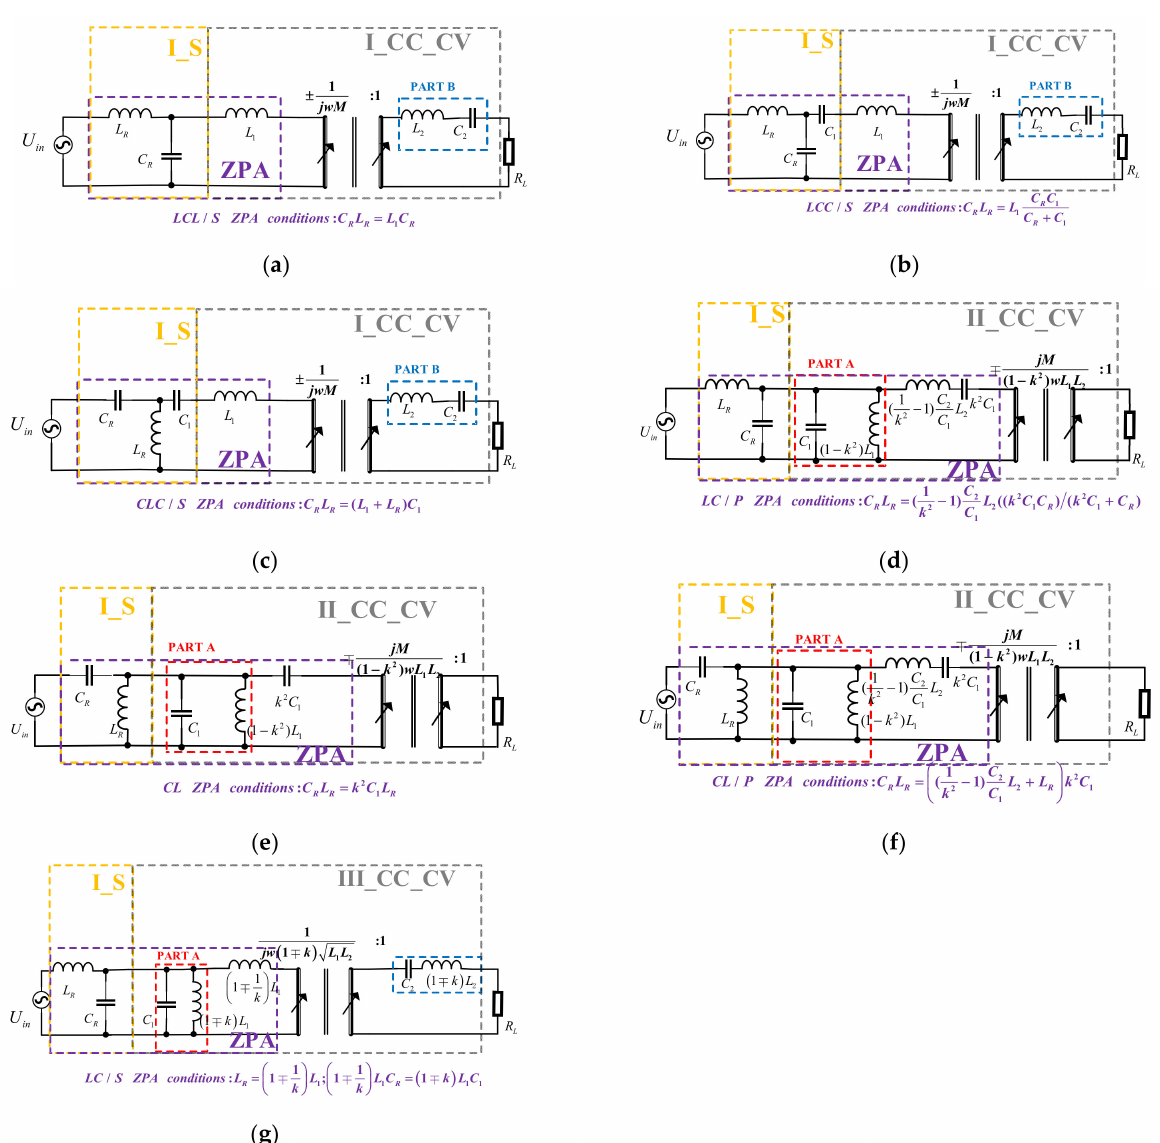
Figure 28. The S_CC_CV compensation topologies: ( a ) LCL/S [22]; ( b ) LCC/S [6,15–17,31,32]; ( c ) CLC/S; ( d ) LC/P; ( e ) CL; ( f ) CL/P; and ( g ) LC/S